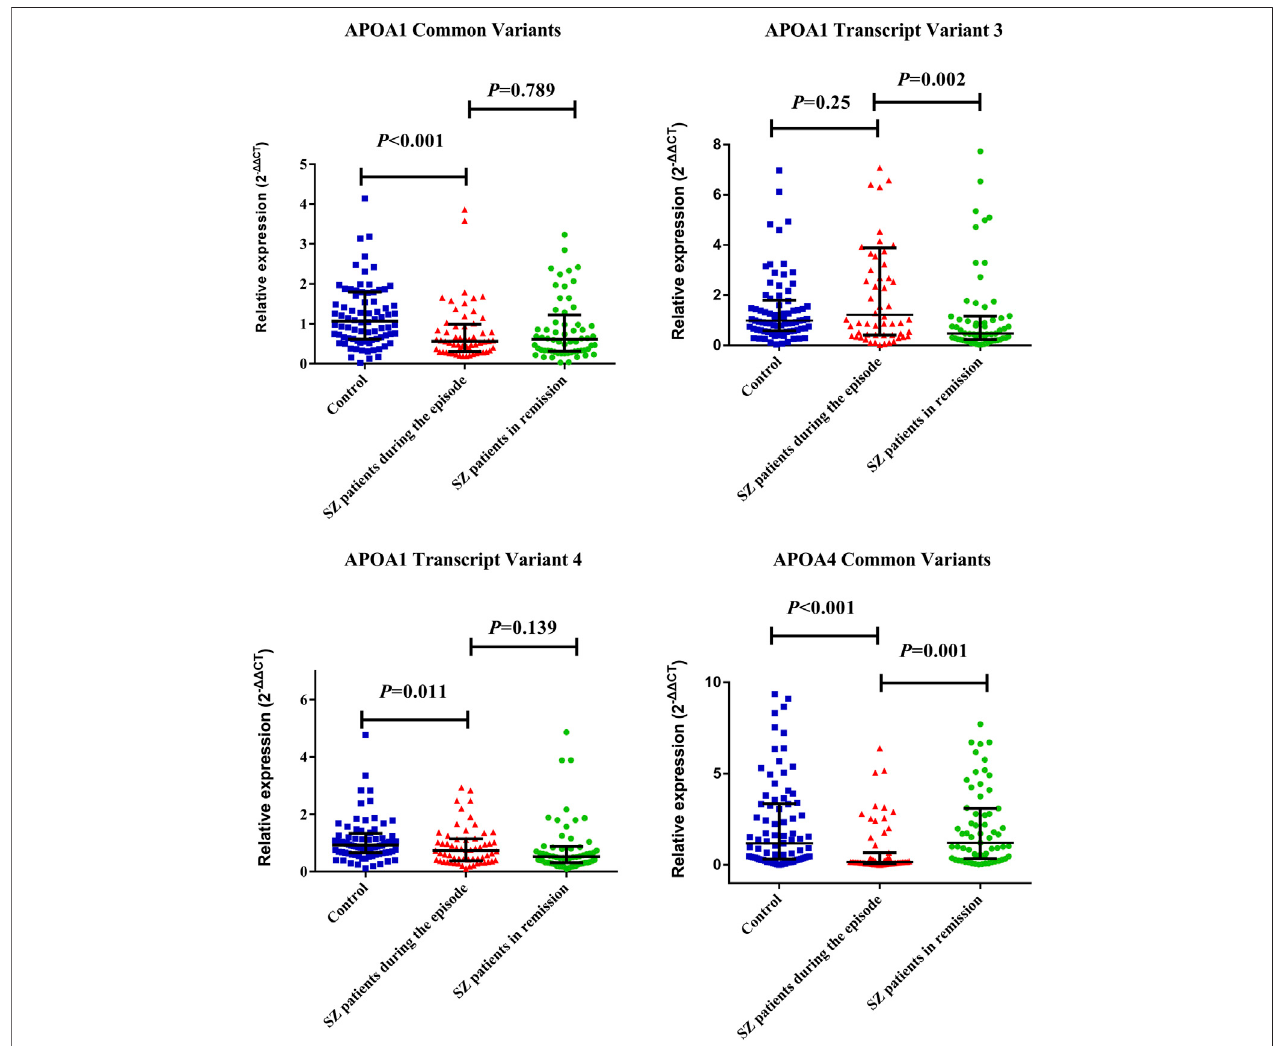
FIGURE1| Distribution ofAPOA1commontranscriptvariants andtranscriptvariant4ofAPOA1 among SZpatients duringtheepisode,patientsinremission,and controls.ThedotsrepresentindividualdataofmRNAlevels(2 − ΔΔ CT ).Theupperlineandlowerlinerepresent75thpercentageand25thpercentage,respectively,andthe medium line represents the median. The medians (IRQs) of common variants and transcript variant 4 levels (2 - ΔΔ CT ) of APOA1 mRNA in SZ during the episode (0.57 [0.31.0.99](0.73[0.38,1.15])weresigni fi cantlylowerthanthatofcontrols(1.07[0.62.1.80](0.93[0.66.1.34]).Boththe p -valueswerelessthan0.05.SZpatientsin remission showed a signi fi cantly decreased APOA1 transcript variant 3 expression level (0.47 [0.24.1.16]) and increased APOA4 mRNA expression level (1.35 [0.35.3.12]) than patients during the episode as above ( p < 0.01).